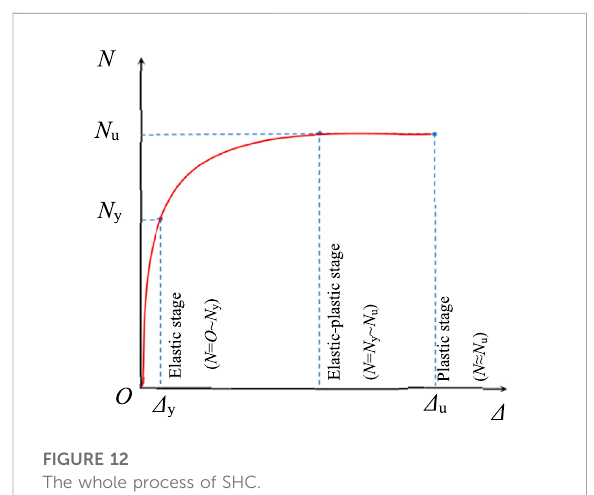
FIGURE 12 The whole process of